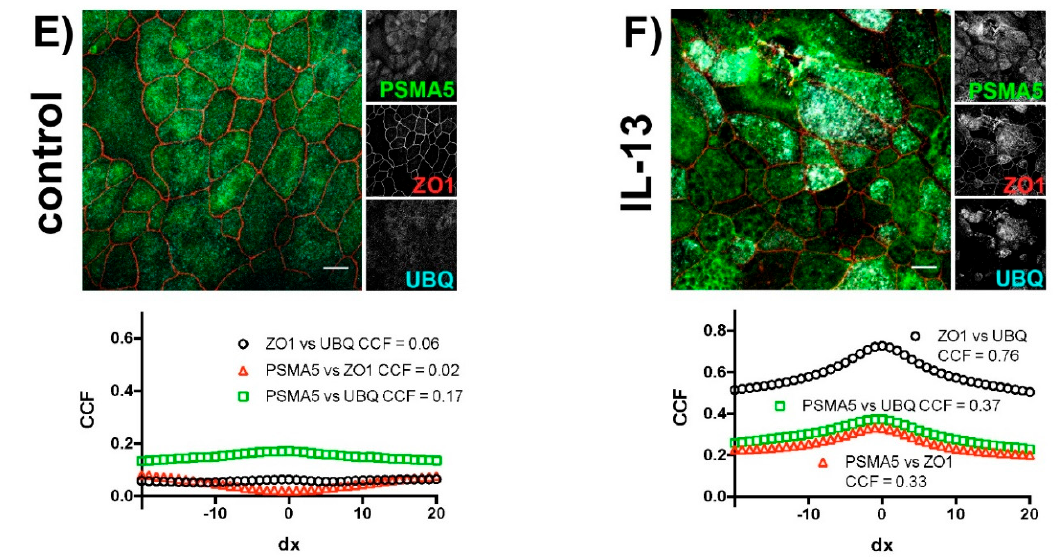
Figure 5. Colocalization of TJ proteins and proteins of the ubiquitin-proteasome machinery. Human tracheal epithelial cells were cultivated at air-liquid interface in the absence (control) and in the presence of IL-13 (IL-13). Images show merged fluorescence channels. Insets at the right give gray scale image for each channel. Van Steensel’s plot below each image gives a cross-correlation coe ffi cient (CCF) plotted against lateral delocalization (dx = 0 to ± 20 pixel). Maxima of cross-correlation coe ffi cient plot are given in the legend for each plot. ( A ) Control epithelia and ( B ) IL-13 treated epithelia immune-stained for Claudin 8 (cldn8, green channel), zonula occludens 1 (ZO1, red channel) and UBE2Z (cyan channel). ( C ) Control epithelia and ( D ) IL-13 treated epithelia immune-stained for Claudin 8 (cldn8, green channel), zonula occludens 1 (ZO1, red channel) and Ubiquitin (UBQ, cyan channel). ( E ) Control epithelia and ( F ) IL-13 treated epithelia immune-stained for proteasome subunit α Type 5 (PSMA5, green channel), zonula occludens 1 (ZO1, red channel) and ubiquitin (UBQ, cyan channel). Scale bars in ( A – F ) represent 10 µ